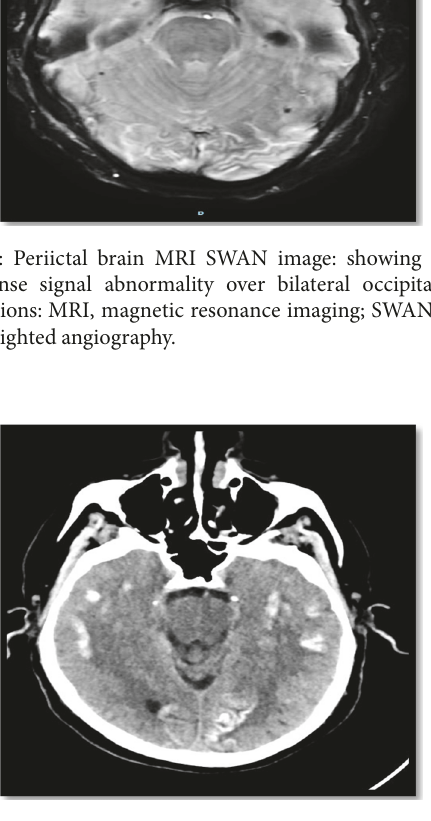
Figure 6: Postictal plain CT of the brain showing no interval abnormality compared to the CT of the brain upon presentation. Abbreviation: CT, computed